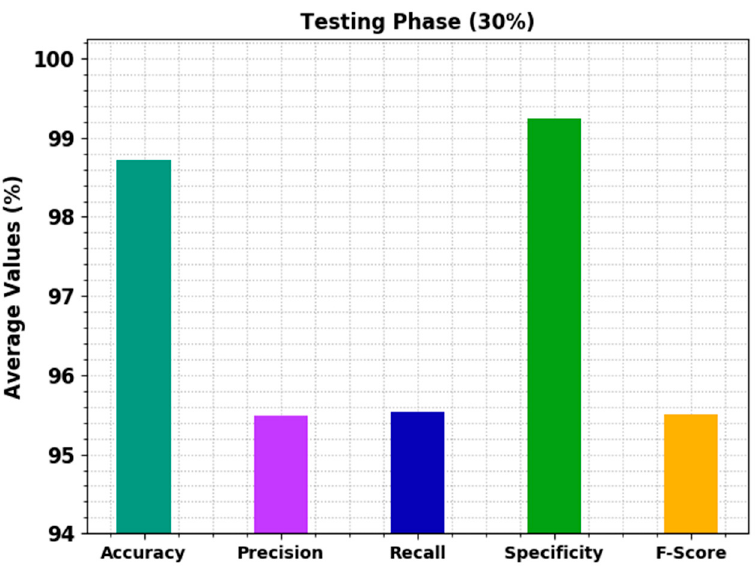
Figure 6. Result analysis of CLBEDC-SND approach under 30% of TS data.